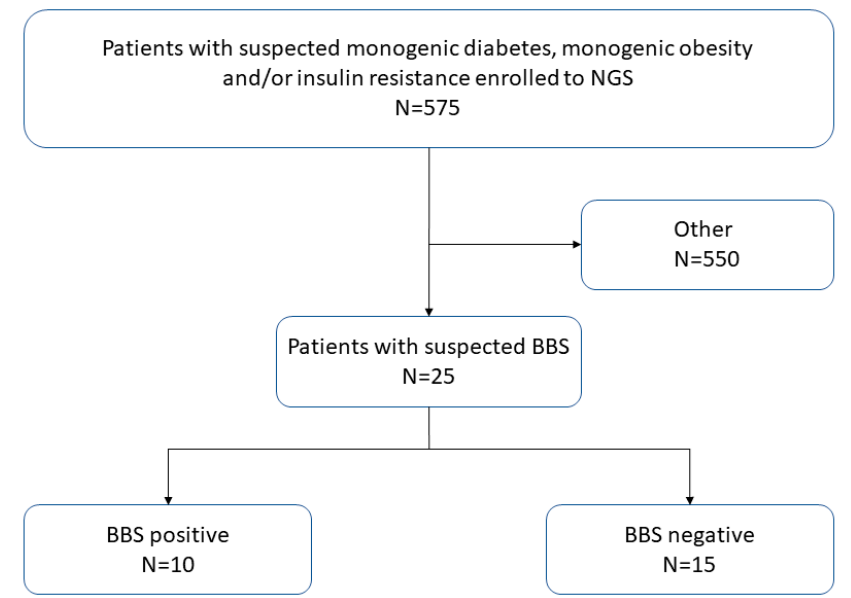
Figure 1. Pathway used on the process of patient recruitment for the present study. NGS—next-generation sequencing; BBS—Bardet–Biedl syndrome. N—sample size.